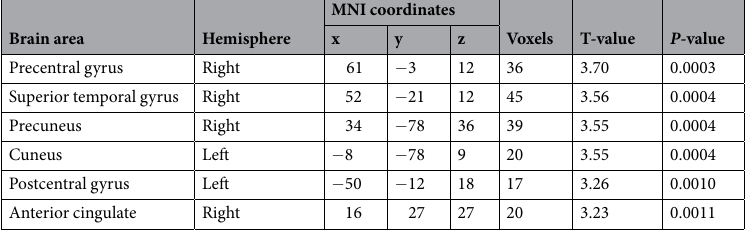
Table 3. Statistics of EEG-informed fMRI analysis. Voxel-wise uncorrected threshold of P < 0.005, k ≥